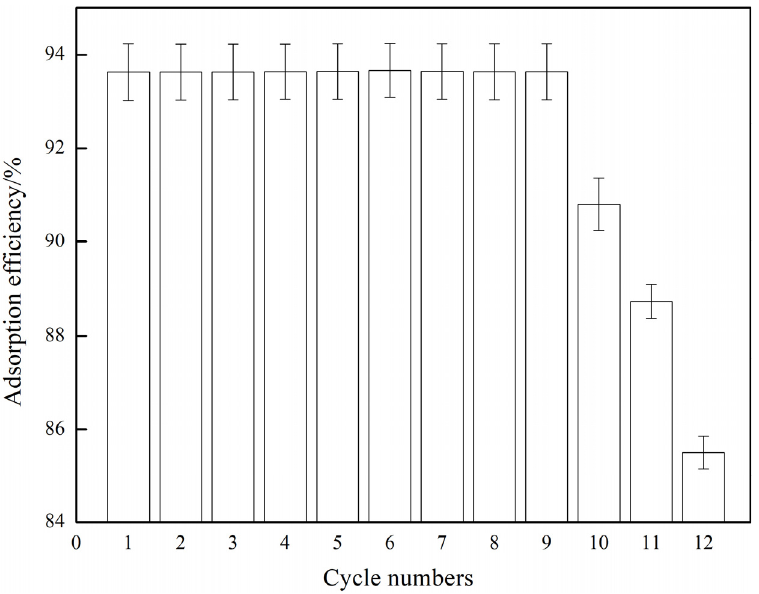
Figure 10. Reusability of Cd-I-MA-co-AN.